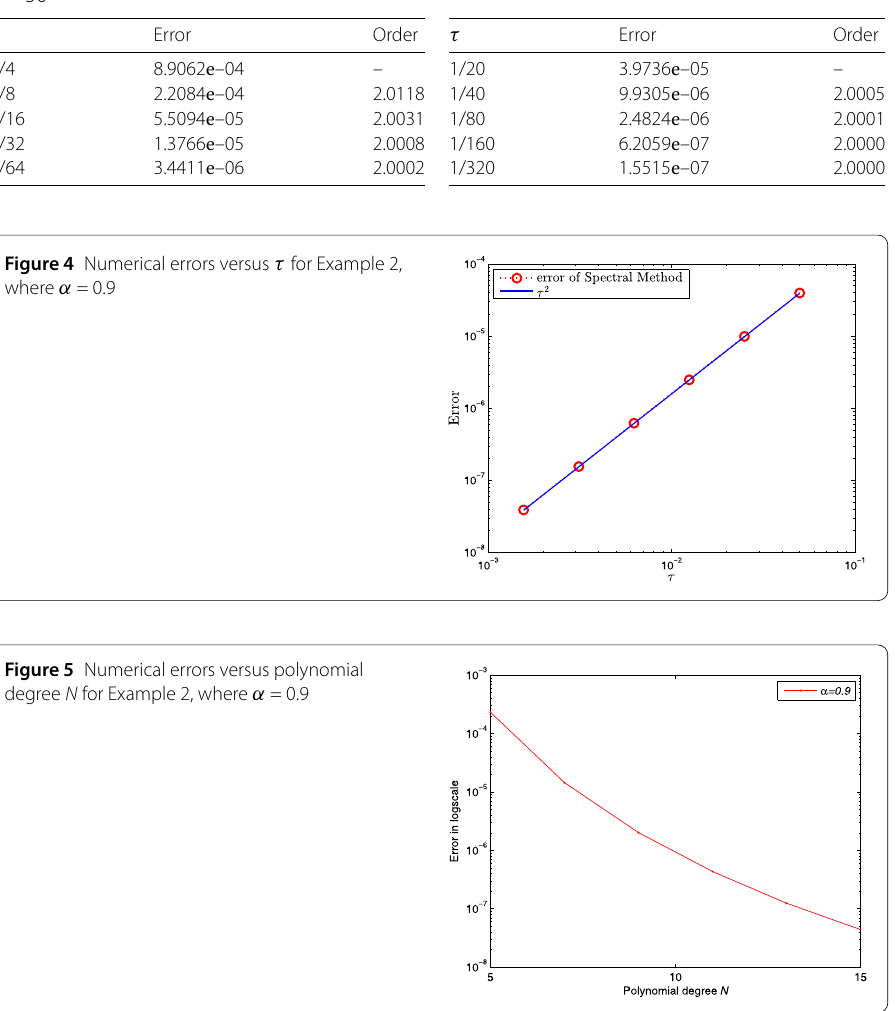
Table 4 The L 2 errors and temporal convergence order with different τ for Example 2, α = 0.9,